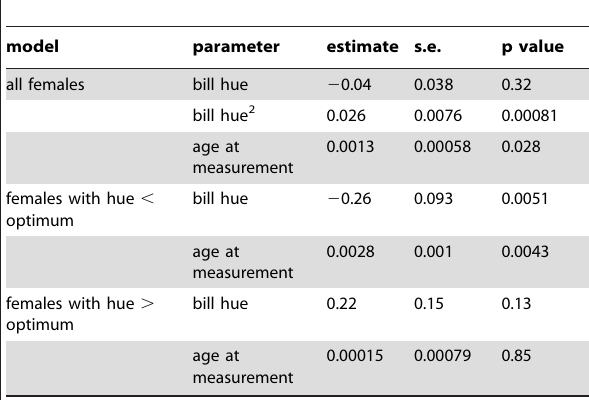
Table 3. Proportional hazard models within females.